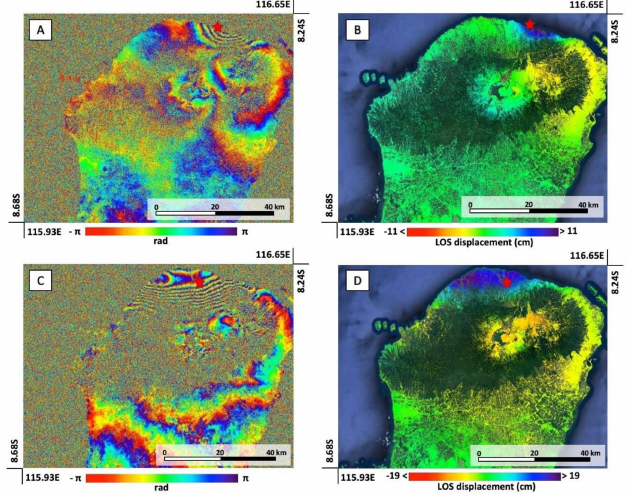
Figure 7. Sentinel-1 results relevant to the Lombok Island (Indonesia) seismic events that occurred during July–August 2018. ( A ) Coseismic interferogram relevant to the 28 July earthquake produced from S1 ascending images (Track 32) spanning the time interval l8 July 2018–30 July 2018. ( B ) Coseismic displacement map related to the interferogram reported in ( A ). ( C ) Coseismic interferogram relevant to the 5 August earthquake produced from S1 ascending images (Track 32) spanning the time interval 30 July 2018–5 August 2018. ( D ) Coseismic displacement map related to the interferogram reported in (C). The red stars identify the epicenters for the two (28 July and 5 August) seismic events.